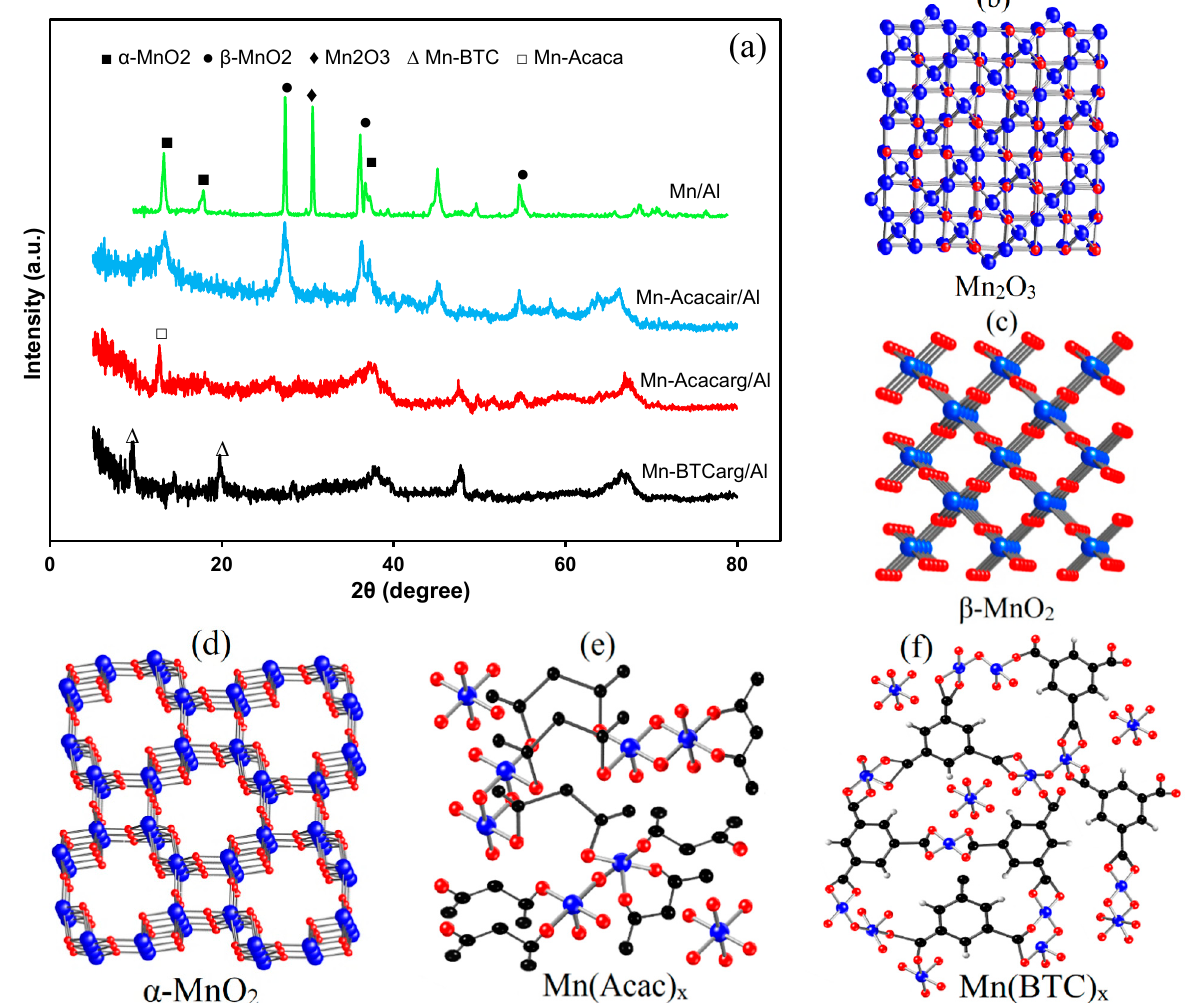
Figure 4. The XRD patterns of the Mn/Al, Mn-Acac air /Al, Mn-Acac arg /Al and Mn-BTC arg /Al catalysts ( a ) and relevant manganese phase structures ( b – f ).